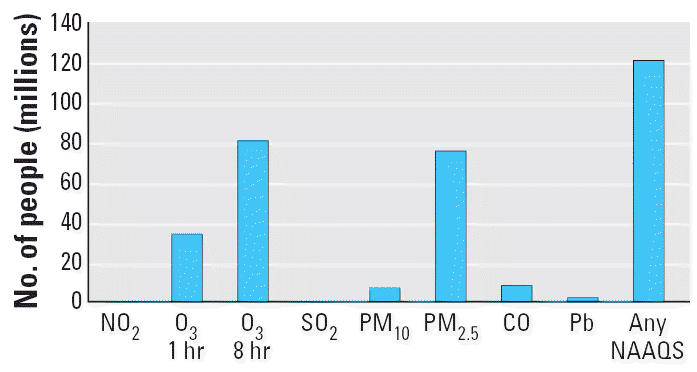
Number of people living in counties with air quality levels above the National Ambient Air Quality Standards (NAAQS) in 2000. Abbreviations: CO, carbon monoxide; Pb, lead. Data from U.S. EPA (2005).